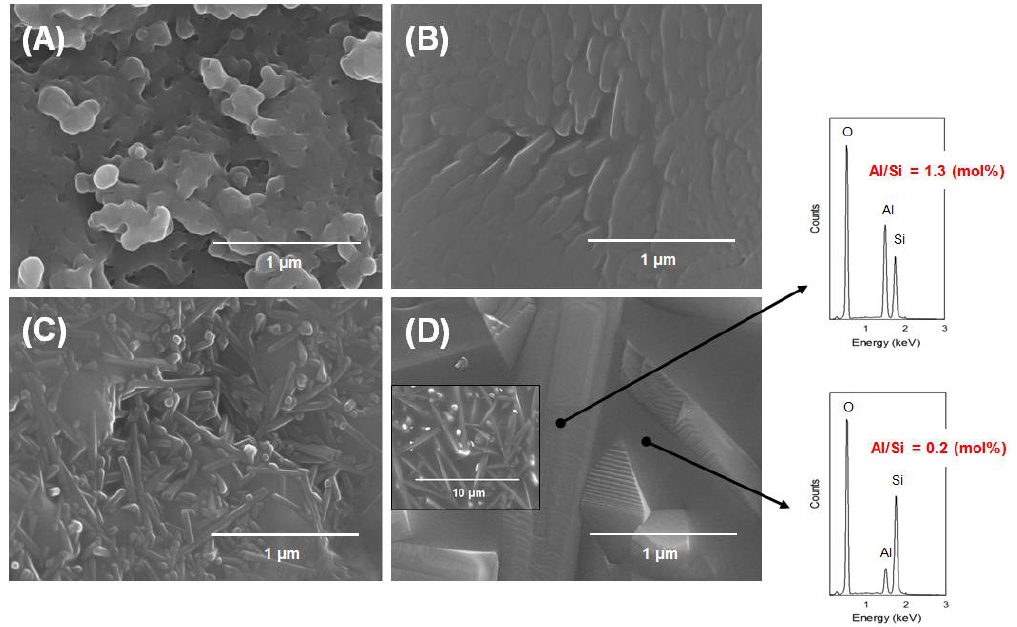
Figure 9. FE-SEM images of the silica-alumina nanoparticle precursor after calcination at different temperatures: ( A ) 950 °C; ( B ) 1150 °C; ( C ) 1250 °C; and ( D ) 1500 °C, and the corresponding EDX spectra obtained for the spots marked by arrows.